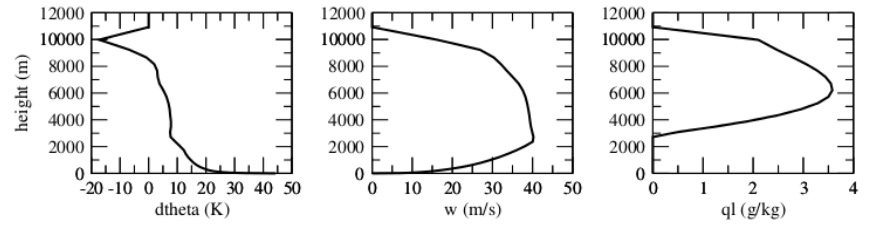
Figure 6. Smoke plume characteristics for the Chisholm fire, as simulated by pyro-EDMF: virtual potential temperature (K), vertical velocity excess (ms − 1 ), and cloud liquid water (gkg − 1 ) are shown. Figure from Rio et al. (2010).